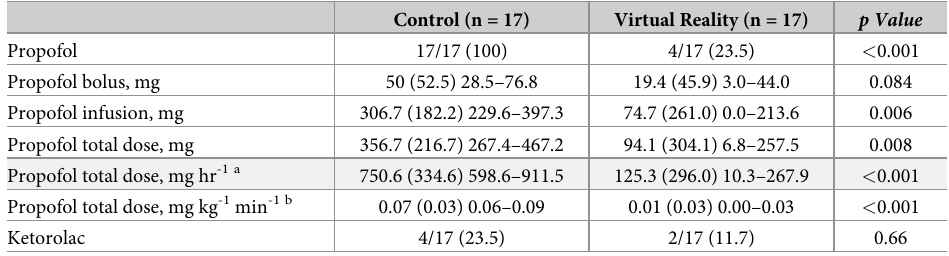
Propofol total dose, mg kg -1 min -1 b Ketorolac 0.66 Values are presented as n (%) or mean (SD) 95%CI depending on variable type. a Primary outcome. b Sensitivity